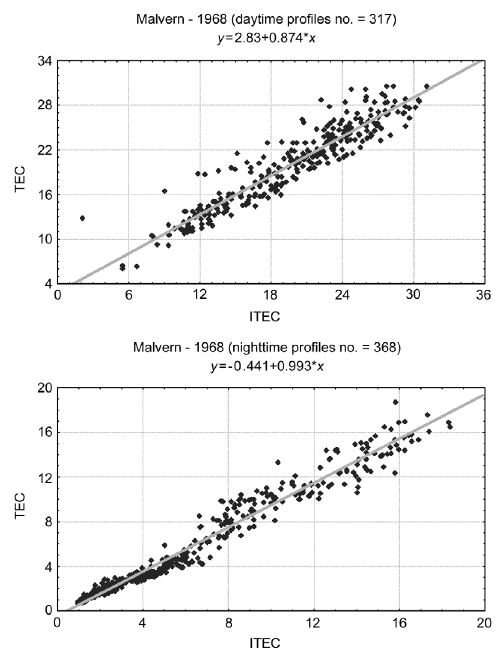
Fig. 10. Statistical results from the comparison be- tween TEC (from ISR profiles) and ITEC (computed from the extrapolated ISR profiles using the H - R method) for daytime cases (upper panel) and night- time cases (bottom